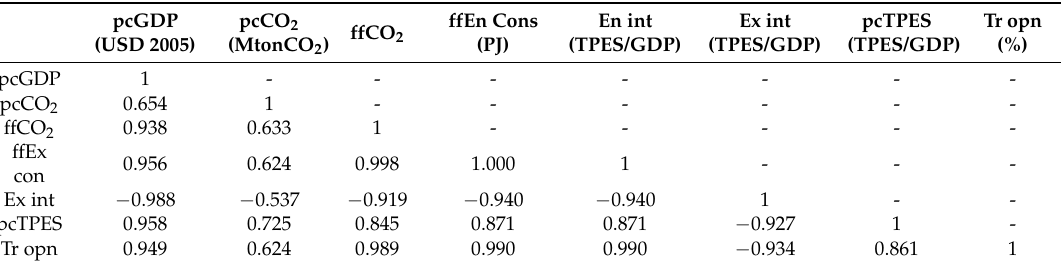
Table 4. Correlation coefficients